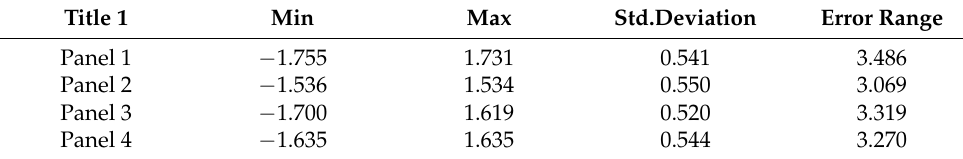
Figure 13. Shape error of free-form concrete panel in repeated fabrication. ( a ) Panel 1, ( b ) Panel 2, ( c ) Panel 3, ( d ) Panel 4). The shape error of free-form concrete panel was 3.486 mm for Panel 1, 3.069 mm for Panel 2, 3.319 mm for Panel 3, and 3.270 mm for Panel 4 as in Table 6. The shape error did not show much change caused by repetition, but the shape error was measured to be within 3.000–3.500 mm. Table 6. Shape error of free-form concrete